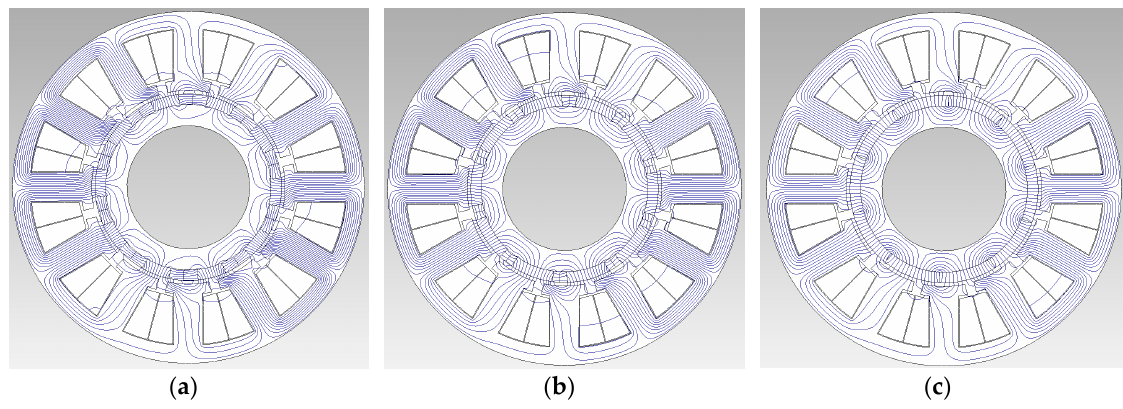
Figure 11. Magnetic Field Distributions across the Motor Area: ( a ) R mp = 0.5; ( b ) R mp = 0.7; ( c ) R mp = 1. For comparison purposes, the electromagnetic performance for the conventional (non-Halbach) motor design with the same parameters in Table 1 is shown in Figures 12–14. All results for the analytical calculations are in agreement with FEA simulations.